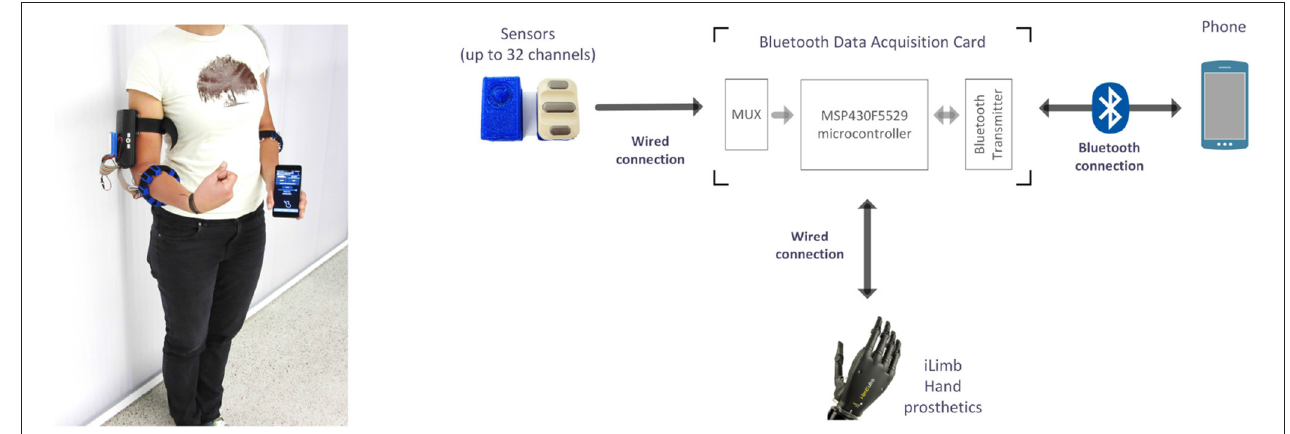
FIGURE 1 | (Left) Overview of the experimental setup. The subject is wearing the mobile system with a wired connection to two sensor bracelets, one endowed with FMG sensors, the other one with sEMG sensors. The Bluetooth data acquisition board is located in a box placed on the right upper-arm. (Right) Block diagram of the system; an i-LIMB prosthetic hand by Touch Bionics (not used in this experiment) can be directly controlled by the